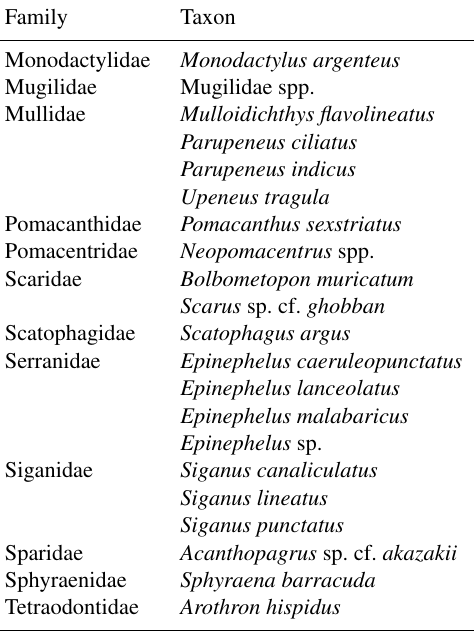
Table A1. The full list of taxa identified by underwater video cam- eras at Bouraké, New